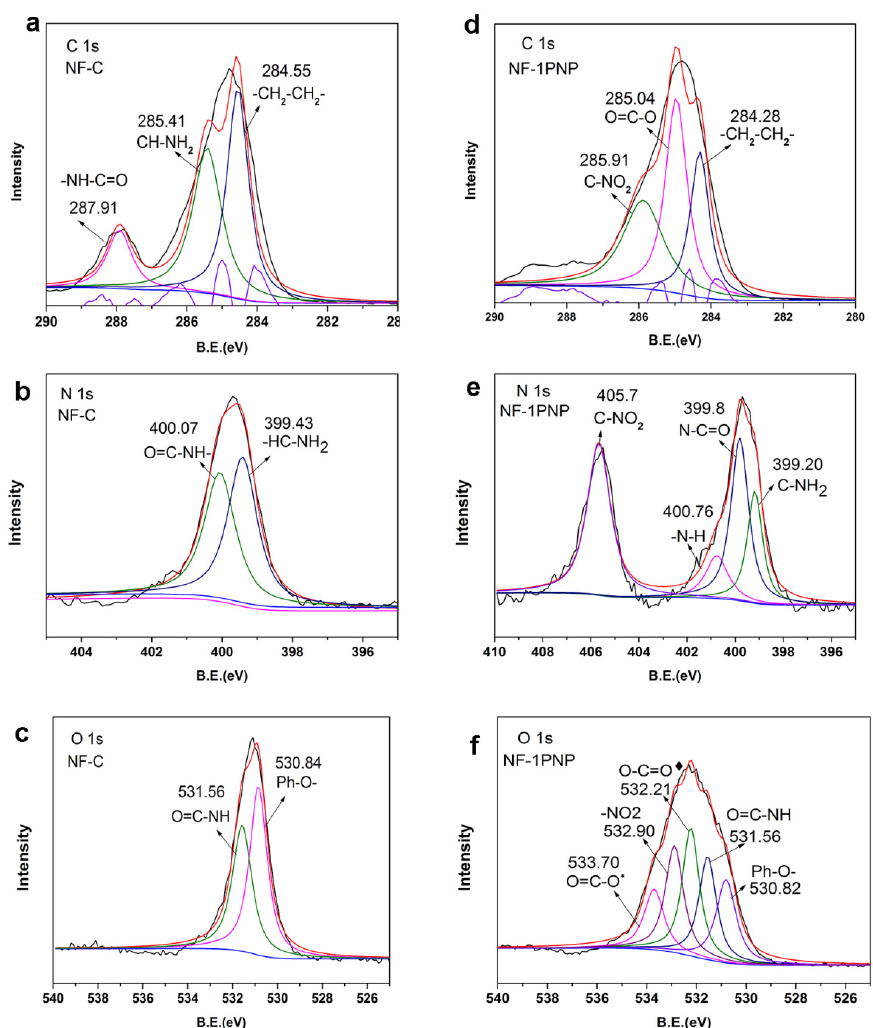
Figure 5displays the effect of PNP concentration on membrane separation perfor- mance in DMF. The performance of NF-C is relatively poor with a rejection of 63% and permeance of 0.1 L m − 2 h − 1 bar − 1 . With the addition of PNP, the separation performance of membrane increased gradually. NF-0.5PNP had a rejection of 83% and a permeance of 0.8 L m − 2 h − 1 bar − 1 . As PNP concentration increased, the permeance of NF-1PNP reached to 2.1 L m − 2 h − 1 bar − 1 , at the same time, the rejection reached 99%. Then, the permeance of NF- 1.25PNP and NF-1.5PNP membrane decreased to 2.0L m − 2 h − 1 bar − 1 and 1.87 L m − 2 h − 1 bar − 1 , respectively. For NF-PNP membrane, it can be noted that the membrane prepared with higher PNP concentration can produce higher rejection.